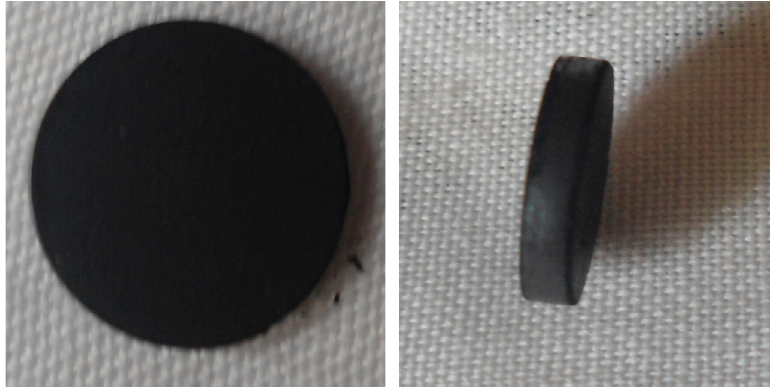
Figure 3. Photograph of one of the fabricated sample.